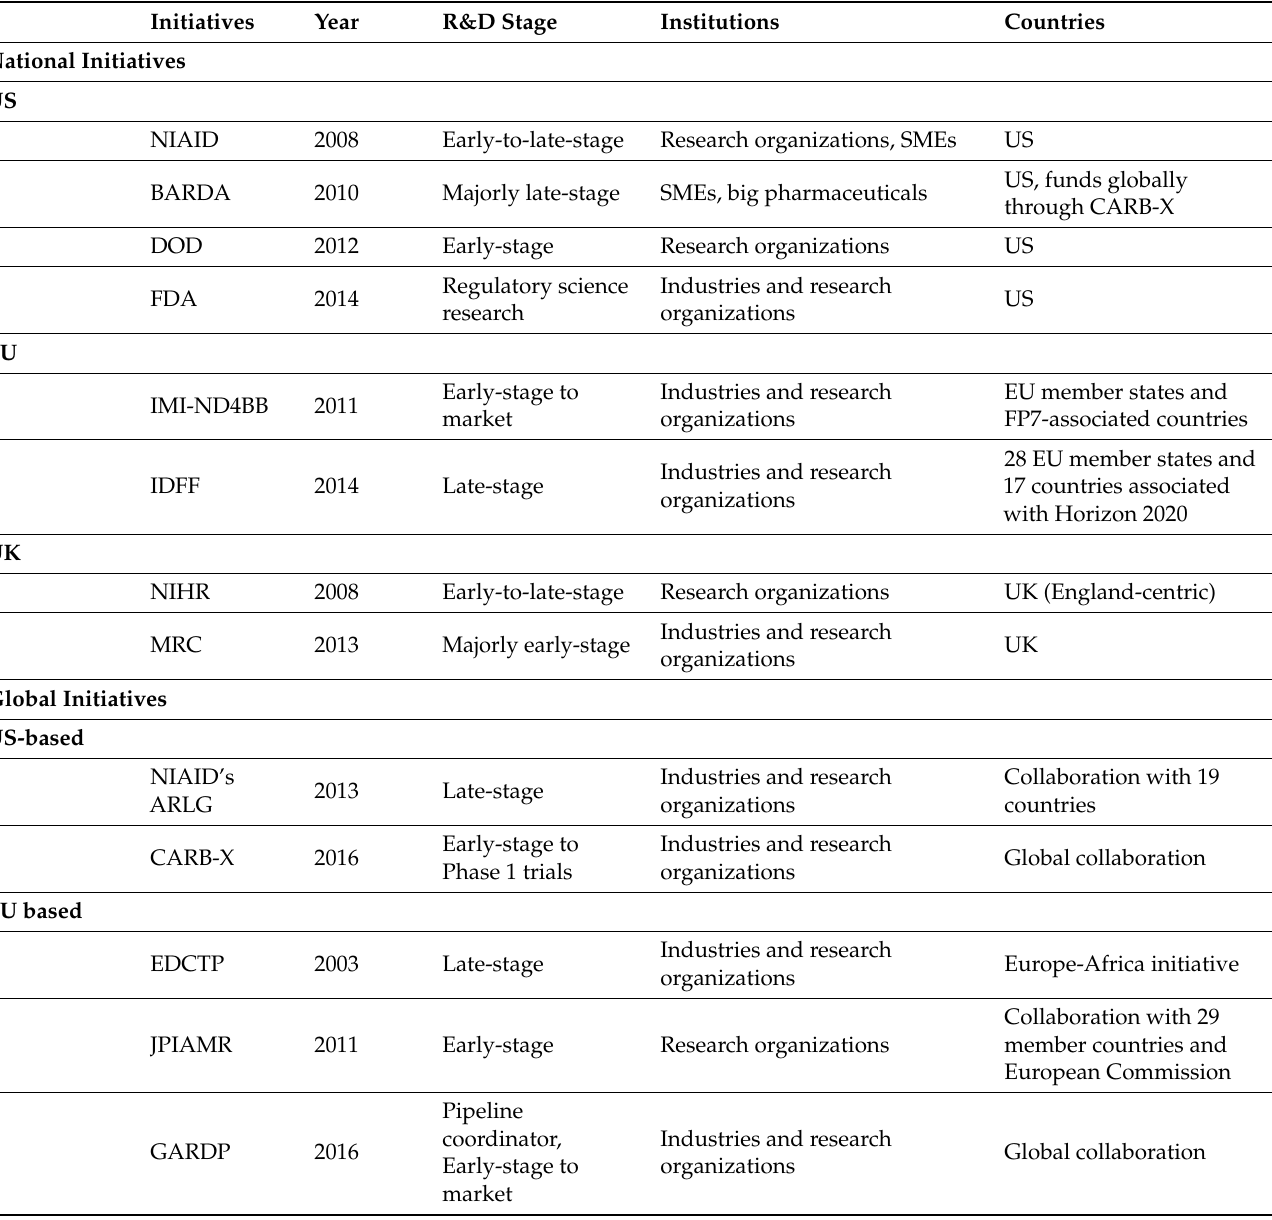
Table 1. Summary of the major national and global push funding mechanisms adopted by the United States (US), European Union (EU), and United Kingdom (UK) to fund antibiotic research and